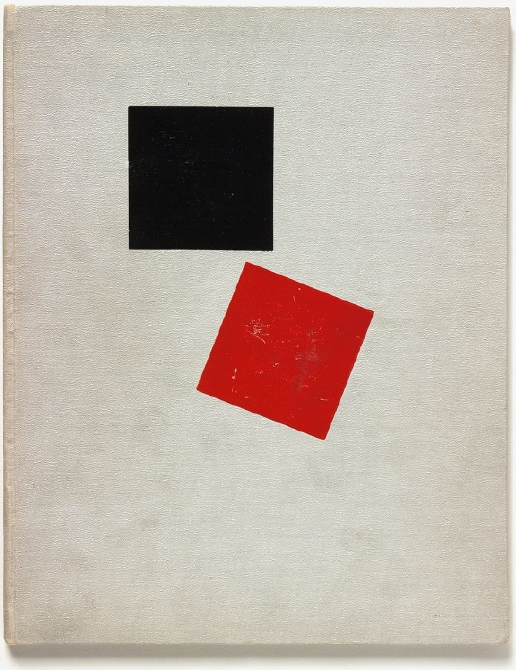
Figure 7. Kazimir Malevich and El Lissitzky, ‘The Story of Two Squares’, Berlin, 1922 (Lissitzky and Malevich 1922). Van Abbemuseum. Photo: Peter Cox.